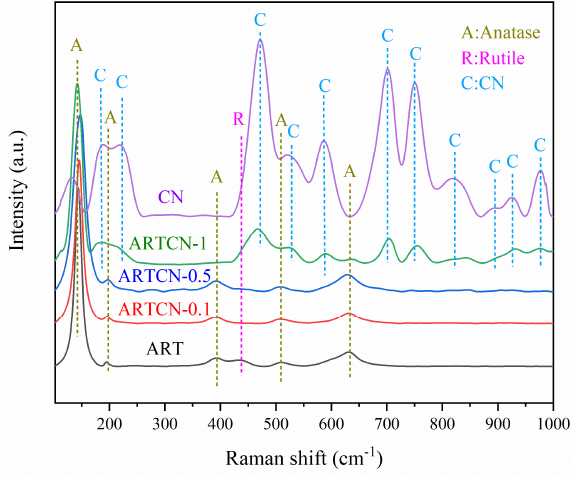
Figure 2. Raman spectra of the samples.